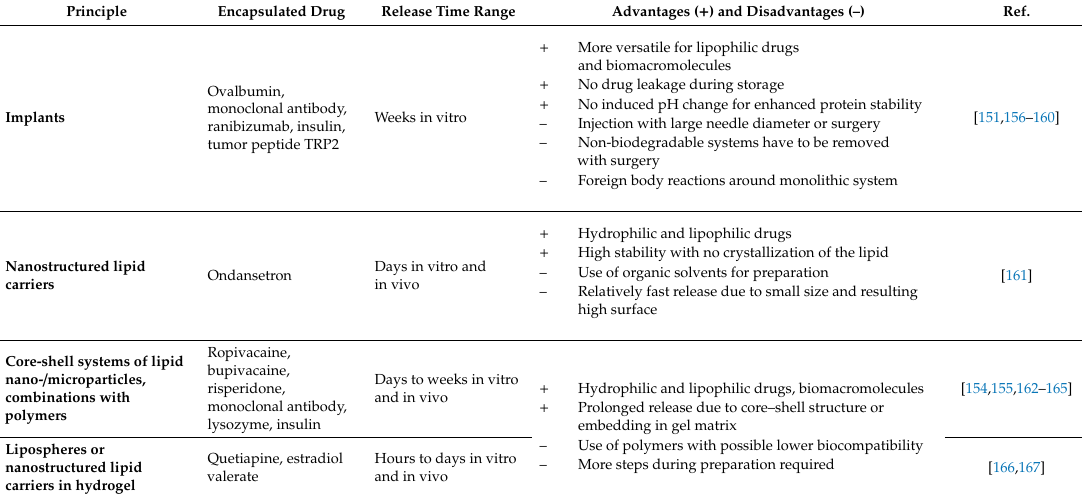
Figure 5. Depot systems based on lipid implants or solid particles made of lipids or mixture of lipids and polymers. ( a ) Reprinted from [151]; ( b ) Reprinted from [152]; ( c ) Reprinted from [153]; ( d ) Right image reprinted from [154] with permission from Elsevier; ( d ) Left image adapted from [155]. Table 5. Overview of depot systems based on solid particles and implants.